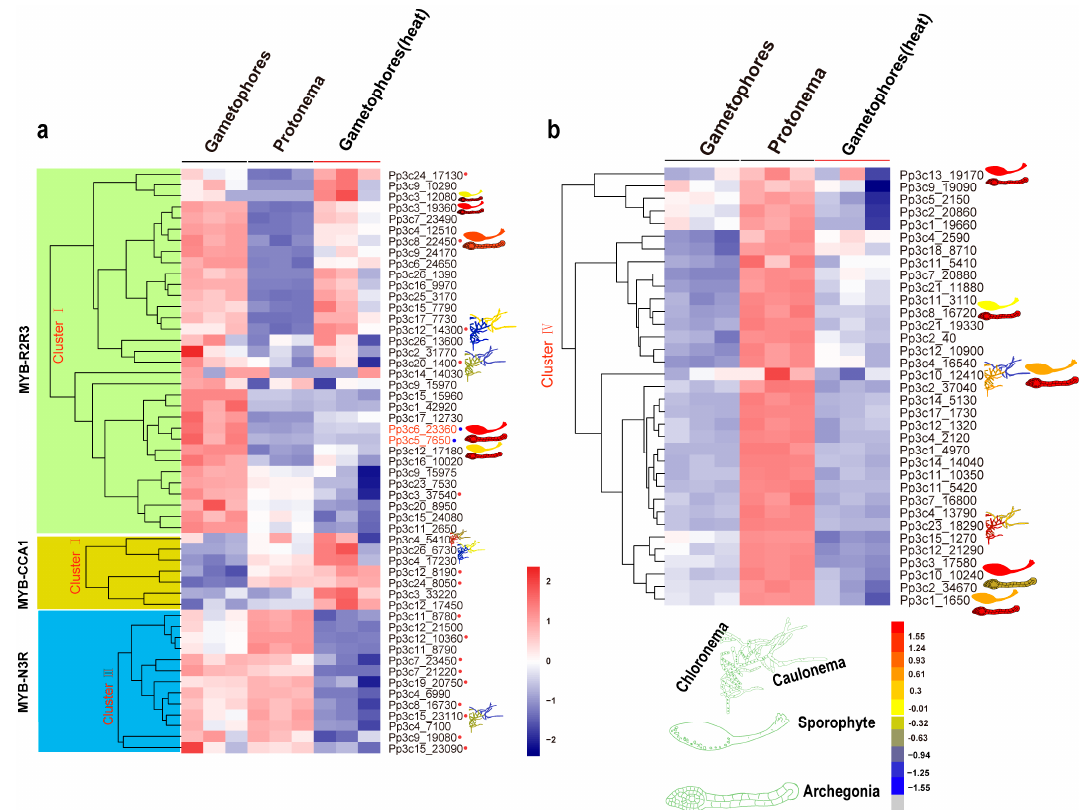
Figure 5. Expression profiles of Physcomitrella patens MYB genes at different developmental stages and in response to heat stress. Relative expression level of MYB genes in plant tissues and organs, in particular cell types, and different developmental stages were retrieved from the BAR database (http://bar.utoronto.ca). ( a , b ) The heat map shows the expression profiles of MYB genes in P. patens at the protonema and gametophore stages and at the gametophore stage after heat treatment. Each box in the heatmap represents a biological replicate. The color represents RPKM normalized log2-transformed value, blue means a downregulation gene, and brick means an upregulation gene. MYBs in the red circle belongs to different subgroups while the blue circle indicates orthologs of MpFGMYB in P. patens .